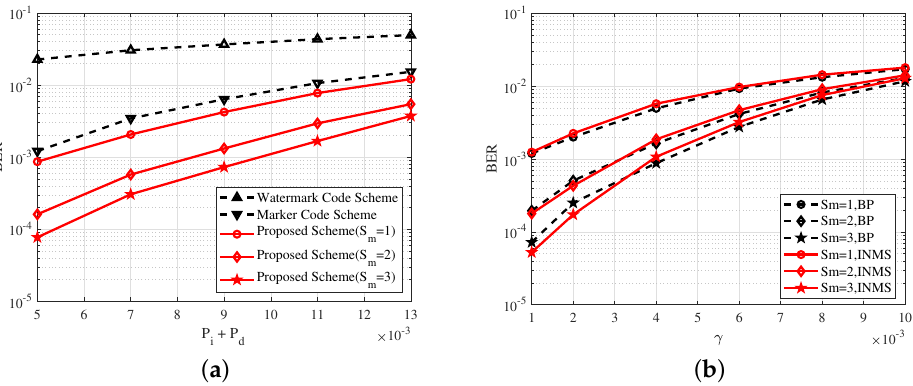
Figure 5. ( a ) BER performance of the concatenated watermark code scheme, the concatenated marker code scheme, and the proposed scheme at γ = 0.002. ( b ) BER performance of the watermark code scheme and the proposed scheme at P i = 0.0005 and P d = 0.0065. S m denotes the maximal number of synchronizations.